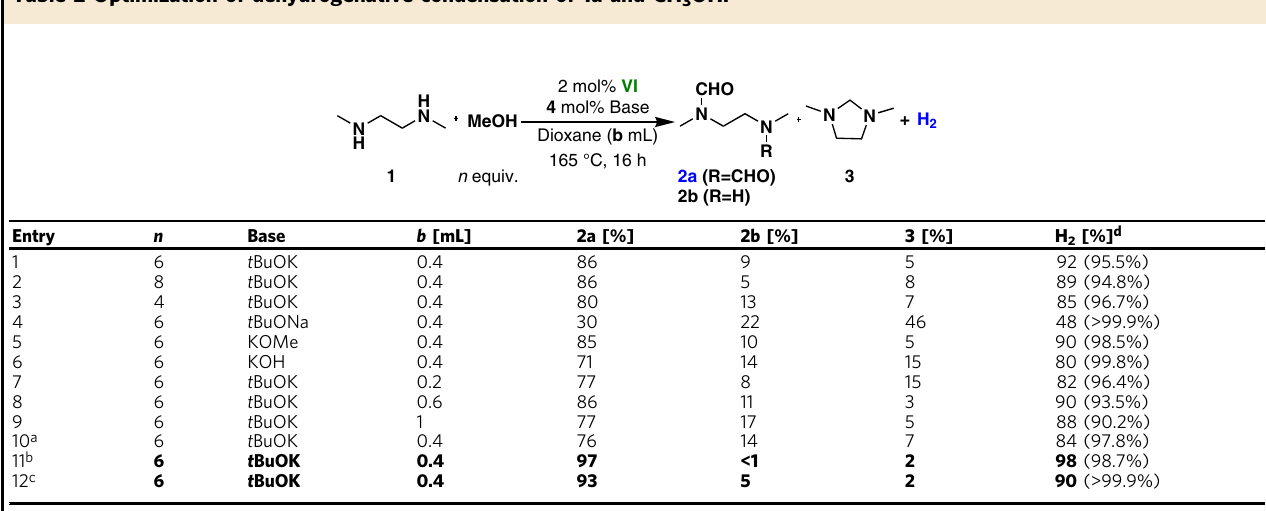
Table 2 Optimization of dehydrogenative condensation of 1a and CH 3